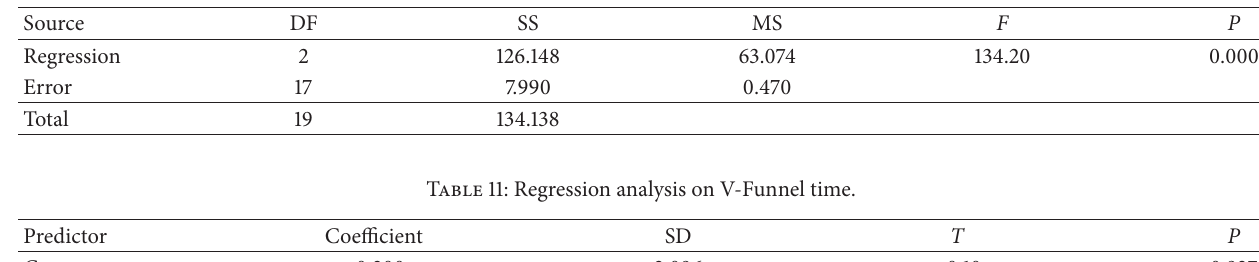
Table 10: Analysis of variance of table spread.